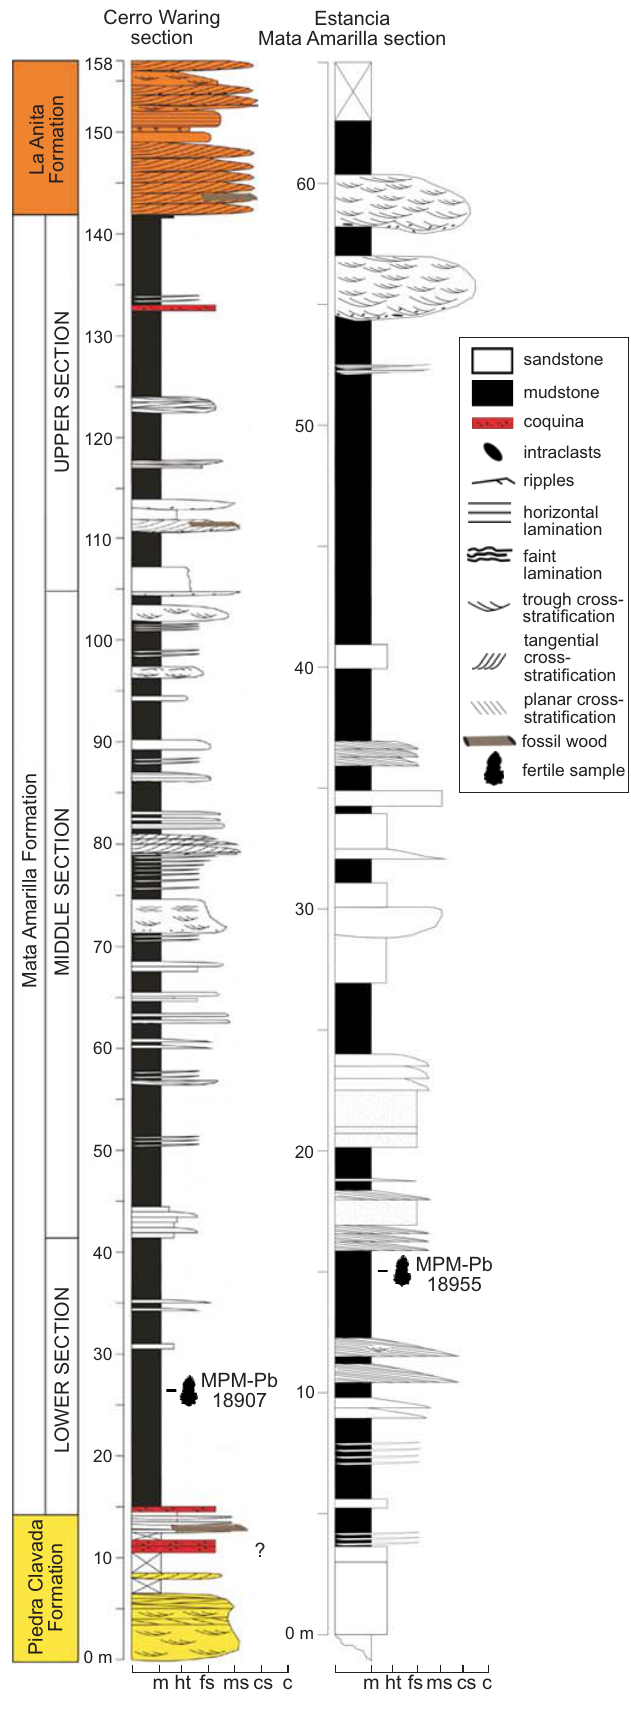
Fig. 2. Stratigraphic sections of the Mata Amarilla Formation at Cerro Waring and Estancia Mata Amarilla localities, showing samples location. Abbreviations: c, conglomerate; cs, coarse sandstone; fs, fine sandstone; ht, heterolitic; m, mudstone; ms, medium